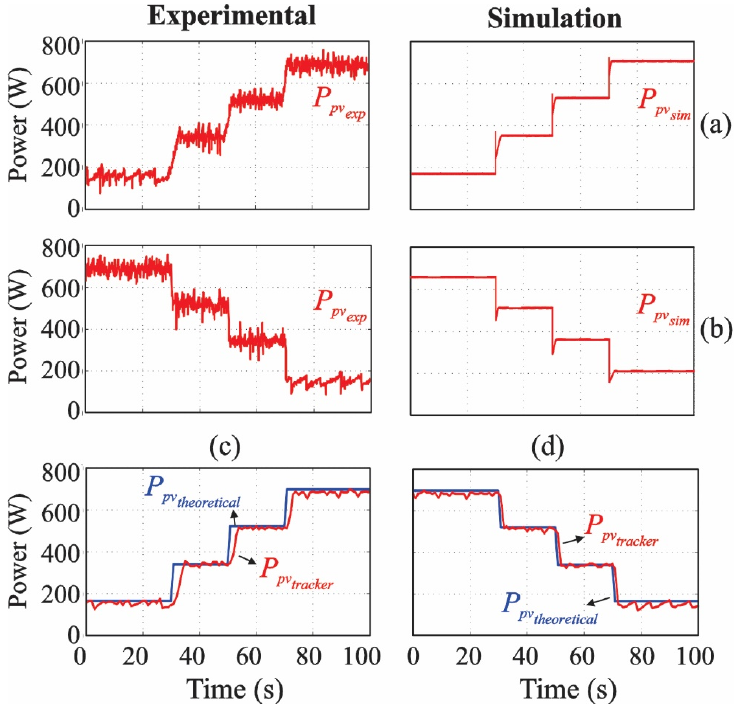
Figure 9. PV array output power under ( a ) increasing and ( b ) decreasing of irradiance with T = 47 °C. Comparison between the theoretical and the tracked maximum power point ( c , d ).